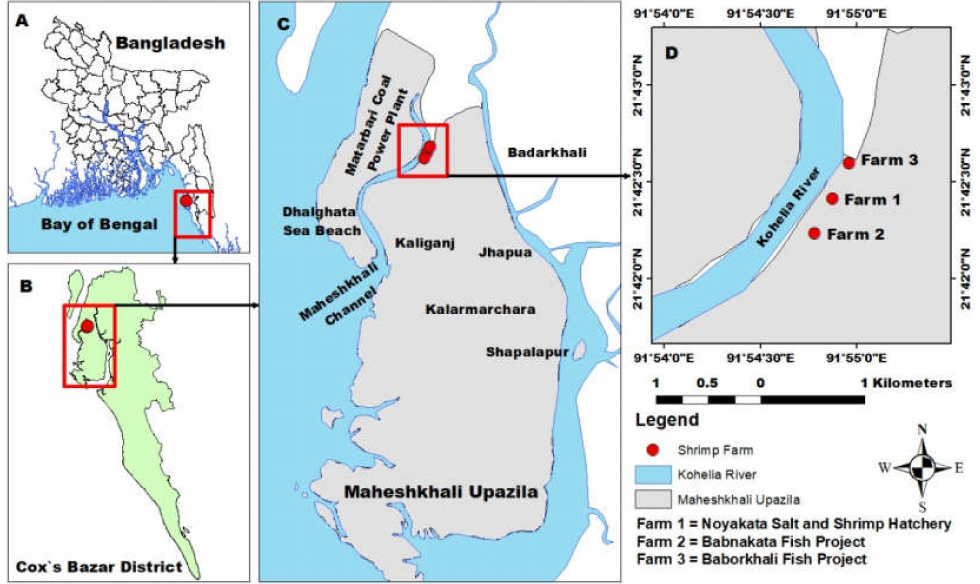
Figure 1. Sampling locations of shrimp and aquaculture sludge from Cox’s Bazar, Bangladesh. (( A )—Map of Bangladesh, ( B )—the Cox’s Bazar district, ( C )—Maheshkhali Upazilla, ( D )—Sampling points near the Kohelia